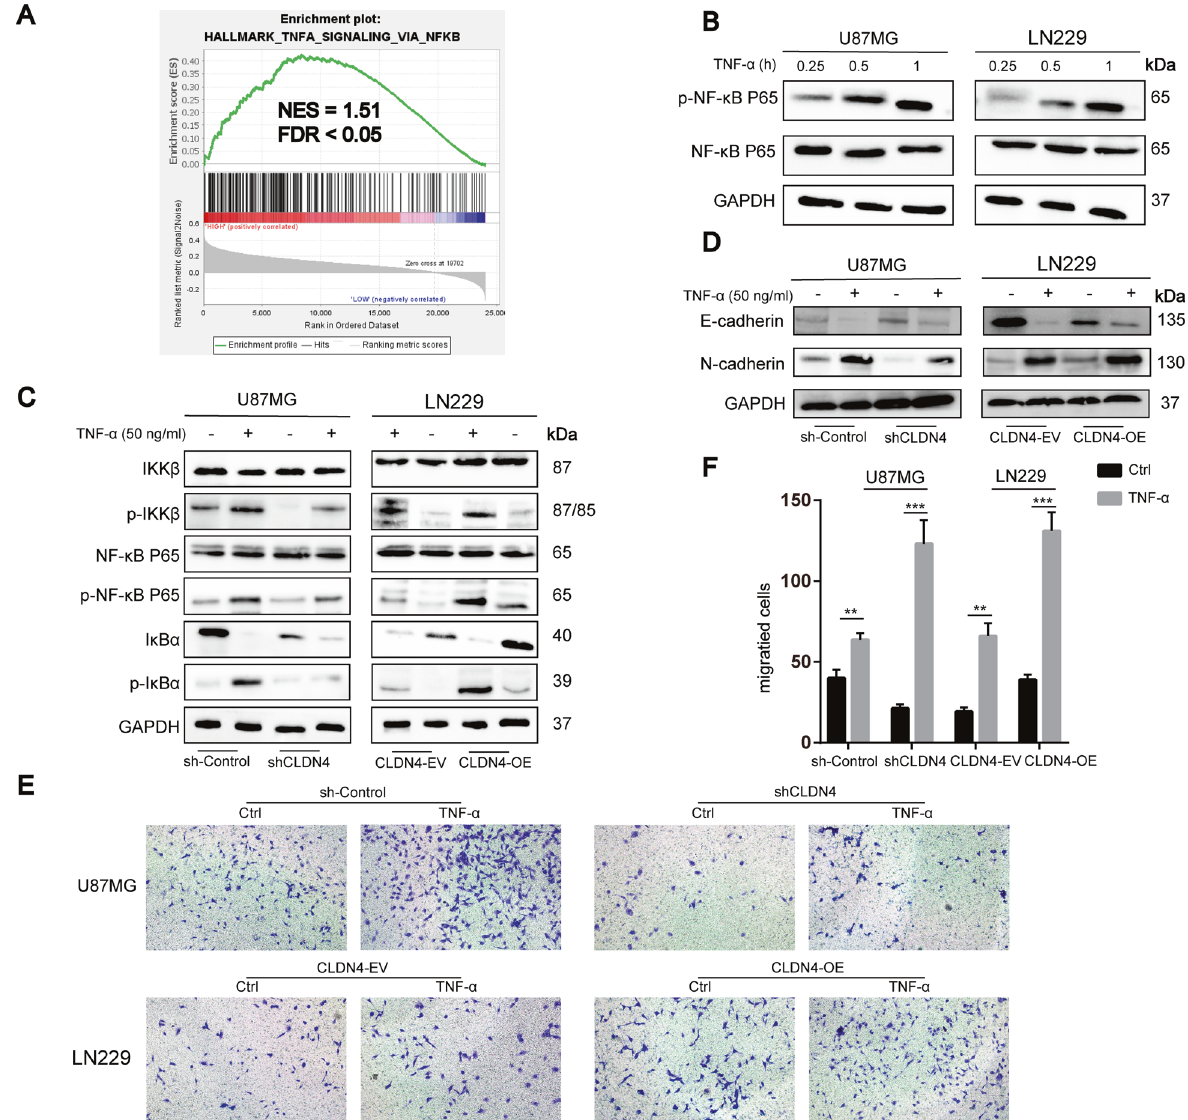
Fig. 4 CLDN4 can regulate NF- κ B activity induced by TNF- α . A According to GSEA, the high expression of CLDN4 in the TNF- α signaling via NF- κ B pathway was enhanced from CGGA-693 data set. B NF- κ B P65 and p-NF- κ B P65 expression were determined by western blotting. C